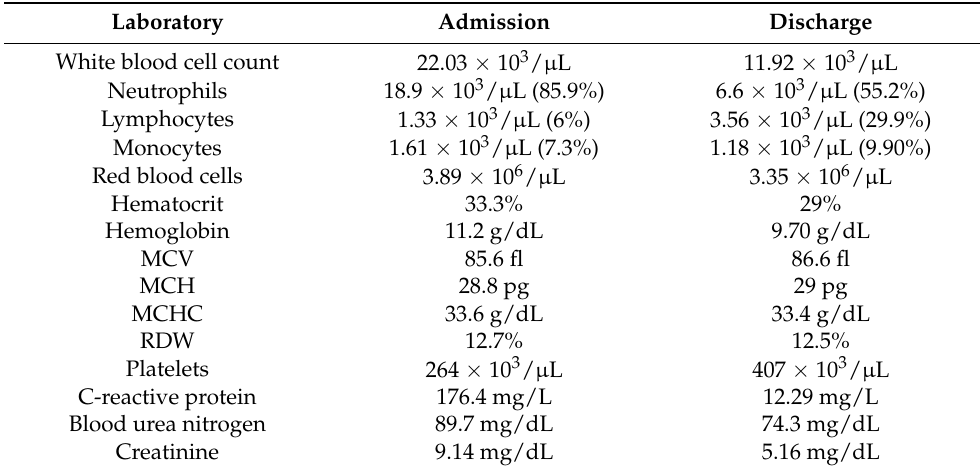
Figure 1. Periareolar lesion with erythematous borders and purulent discharge. Table 1. Laboratory findings.